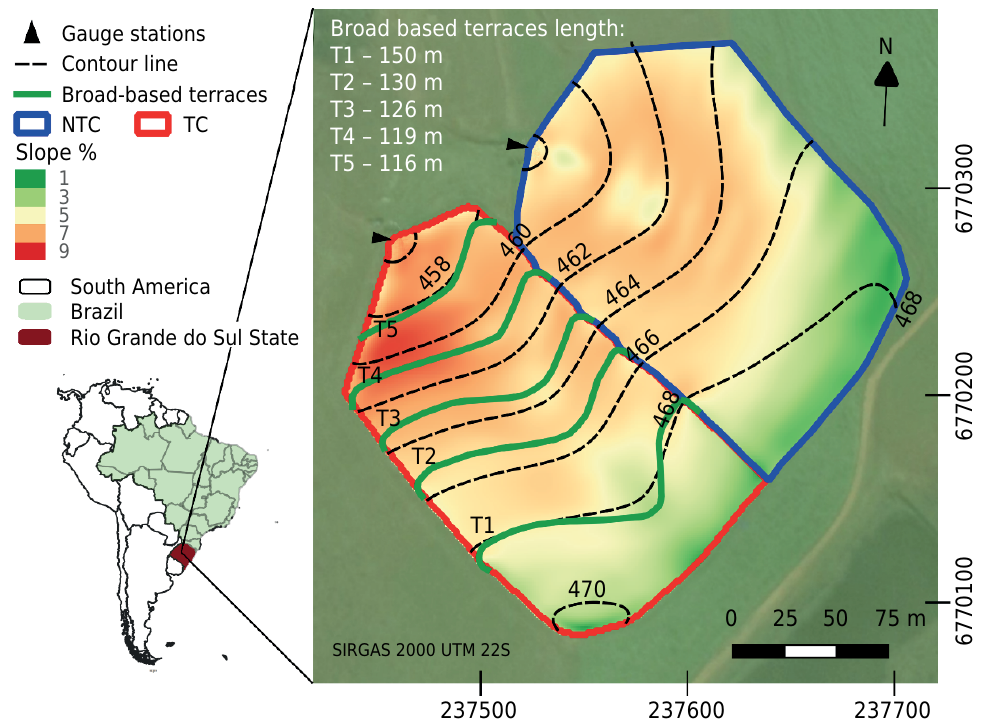
Figure 2. Location and slope characterization of the non-terraced catchment (NTC) and terraced catchment (TC) in Rio Grande do Sul State, southern